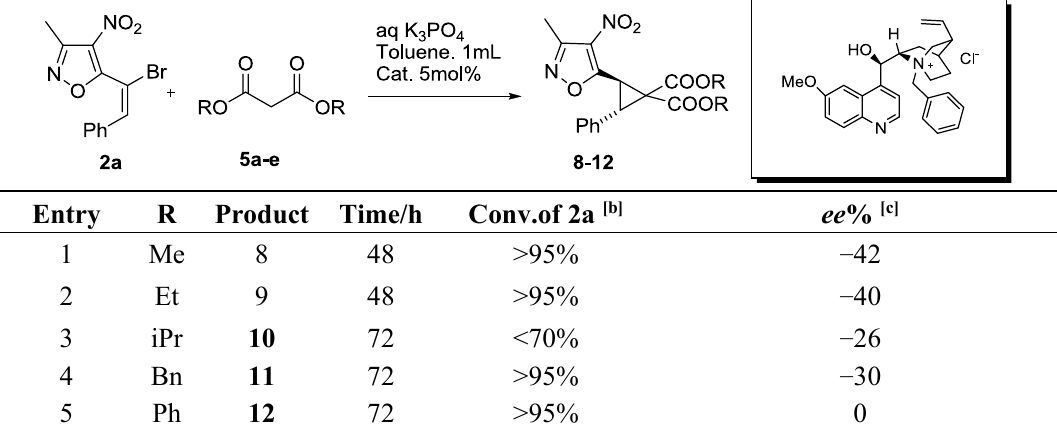
Table 2. Catalytic (MIRC) reaction of 2a with dialkyl malonates [a] .